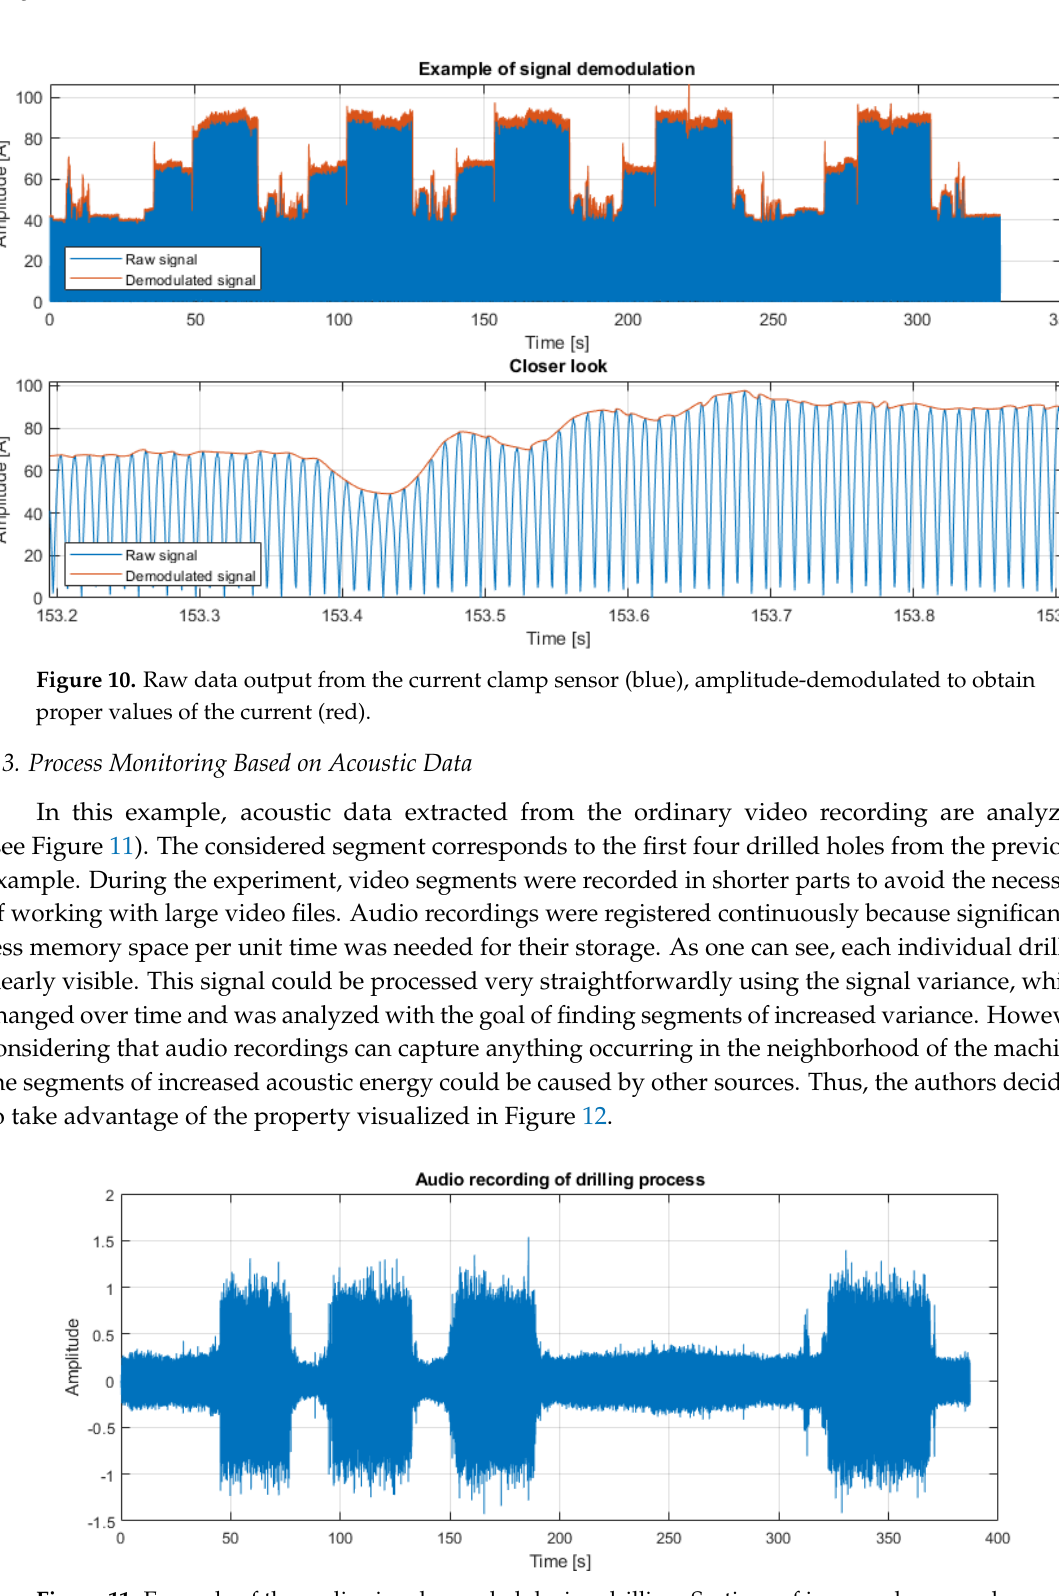
Figure 11. Example of the audio signal recorded during drilling. Sections of increased energy show individual